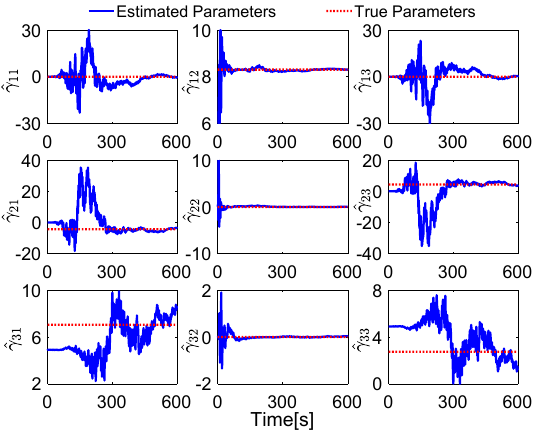
Figure 6. Comparison between estimated parameters and true parameters.